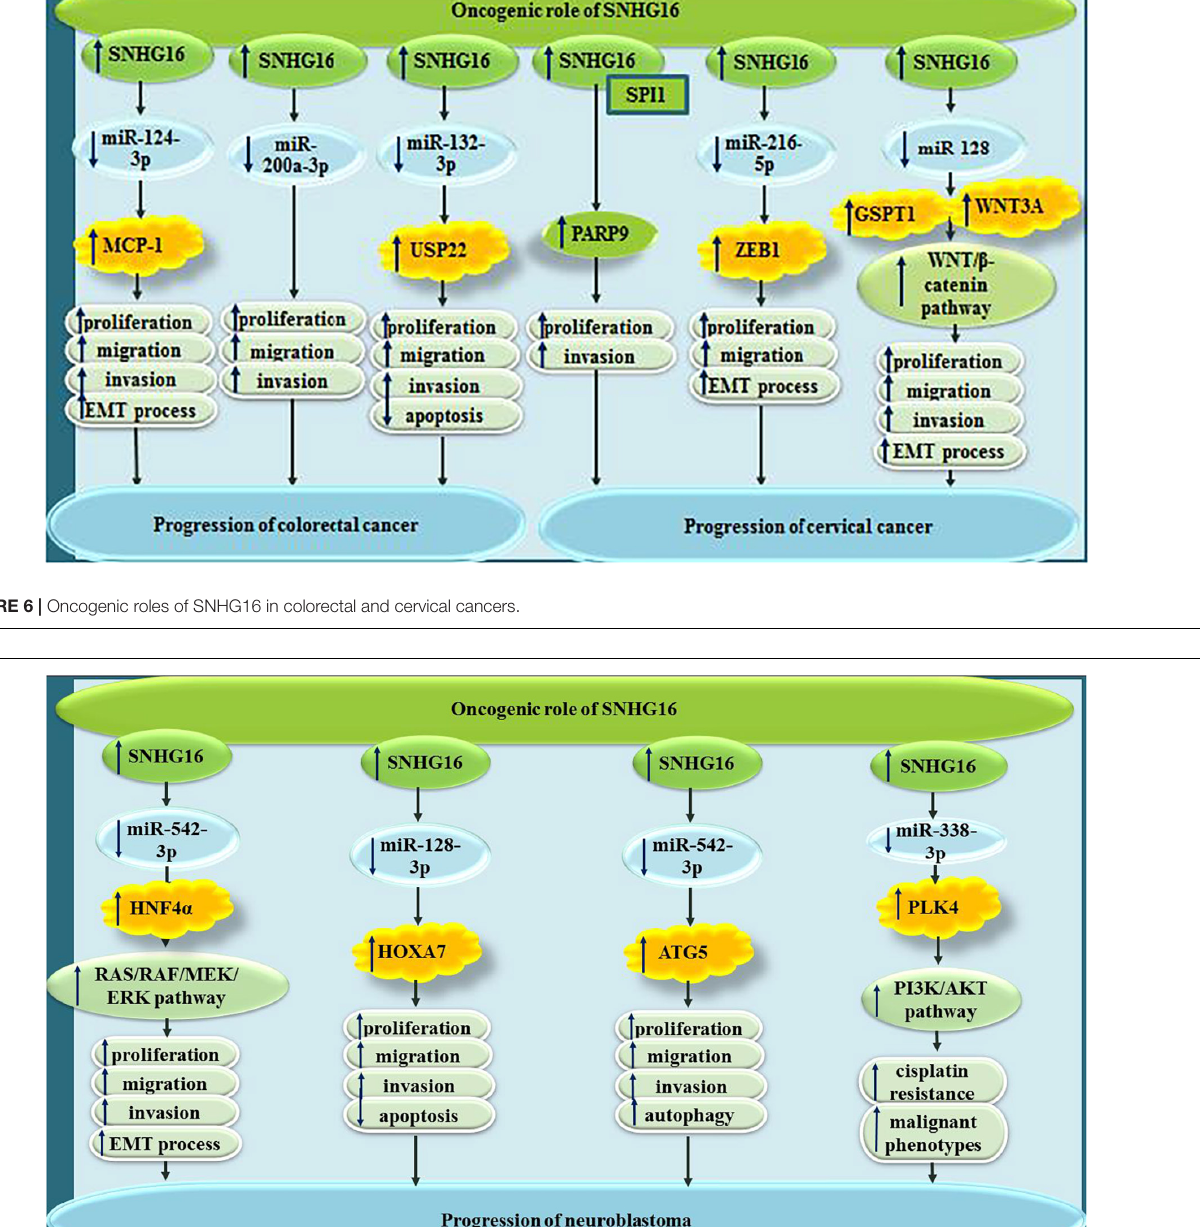
thus promoting malignant behaviors of cells (Tao et al.,